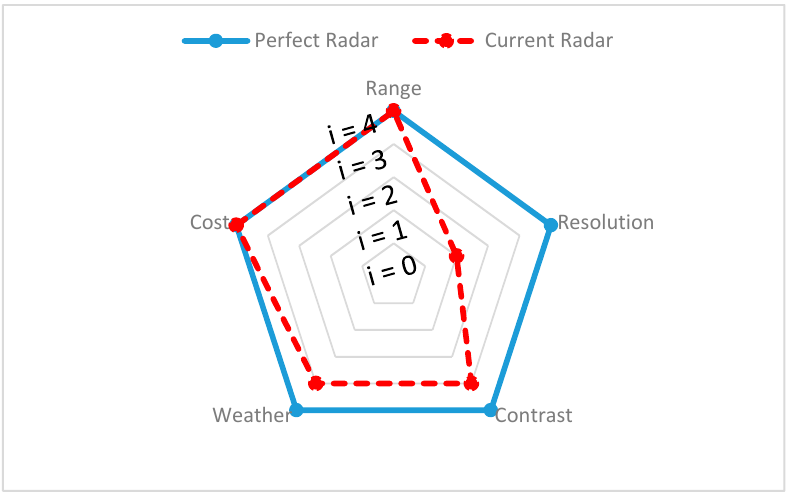
Figure 3. Performance gap for radar sensor based on the scores gathered.